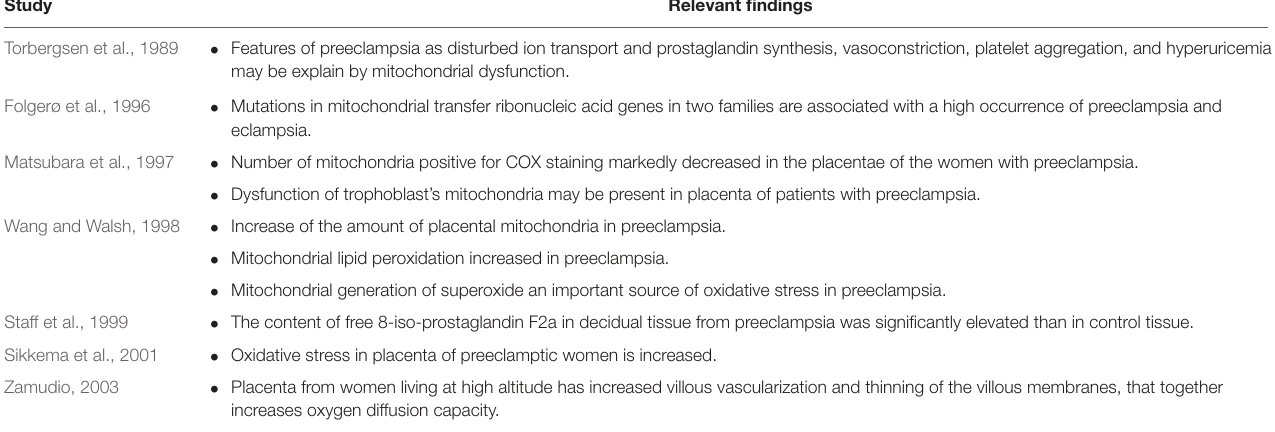
TABLE 1 | Studies involving the activity of the mitochondria during